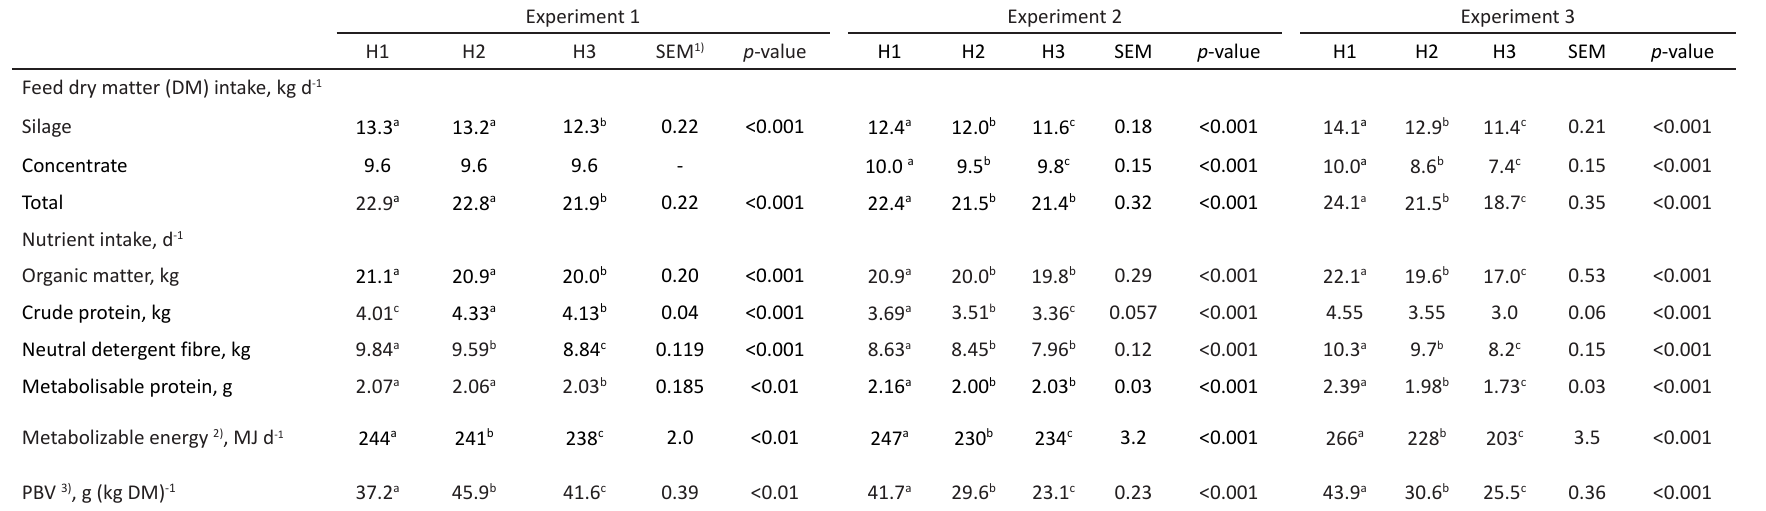
Table 4. Feed and nutrient Intake of cows offered first (H1), second (H2) and third cut (H3) grass silages across different